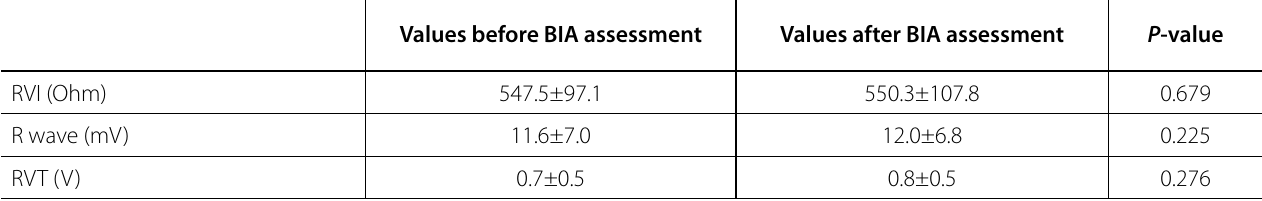
Data described as mean and standard deviation. RVI=right ventricle impedance; RVT=right ventricle